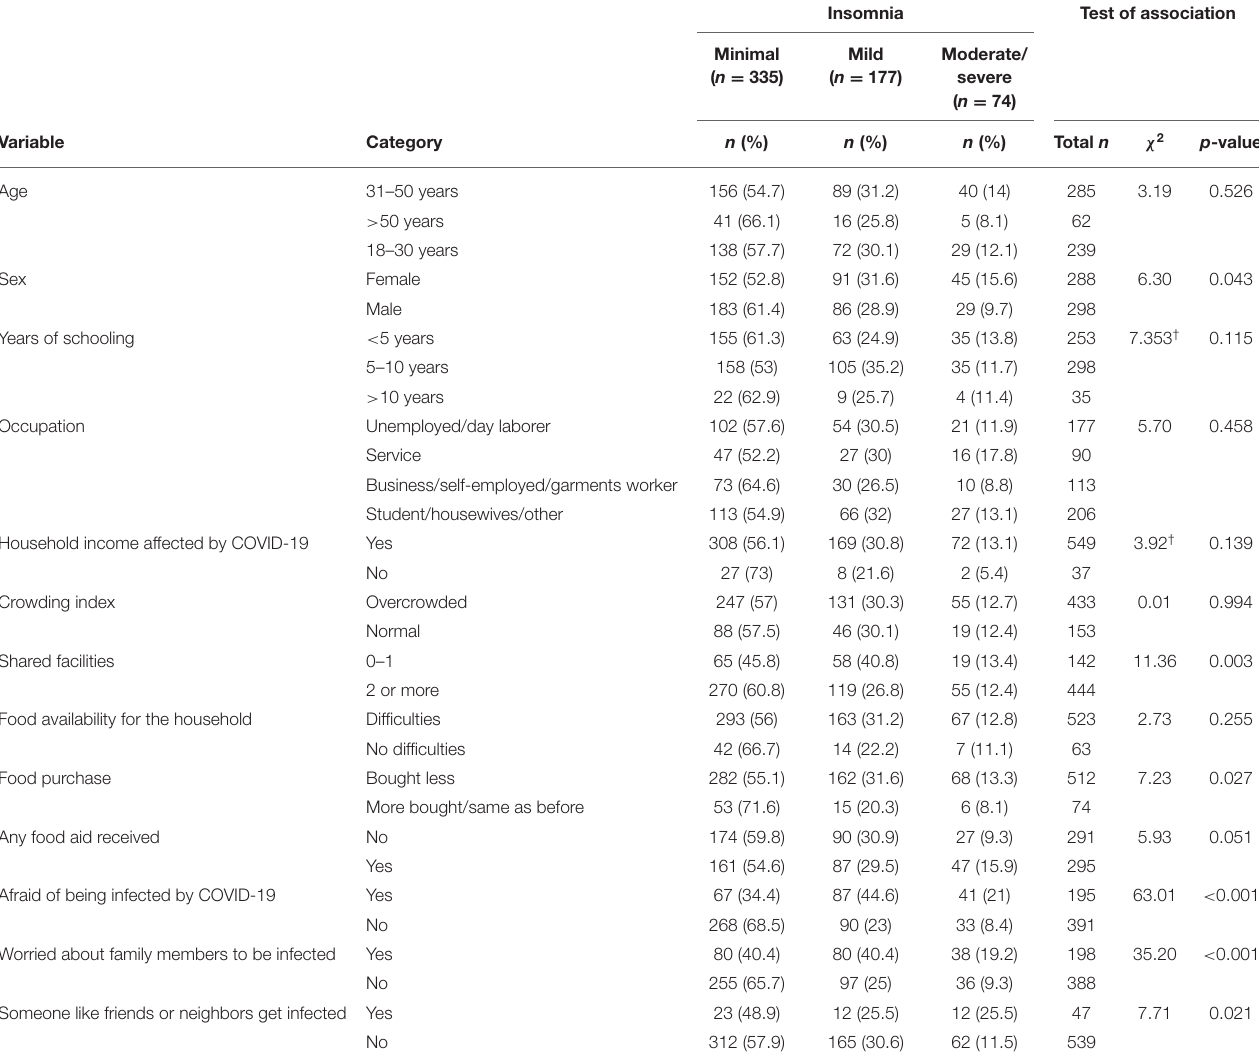
TABLE 3 | Associations between independent variables and levels of